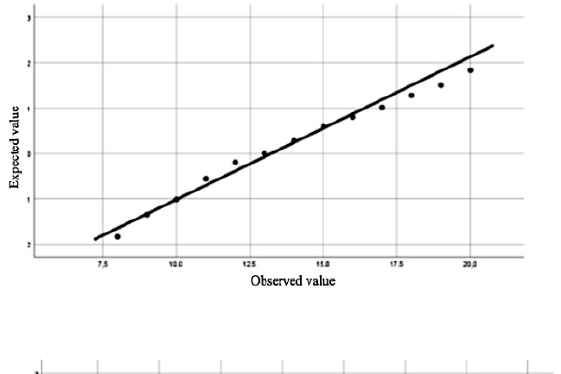
Table 5 collects the values obtained in the three factors studied: F1 (Personal liberties), F2 (Civilian constraint) and F3 (Social